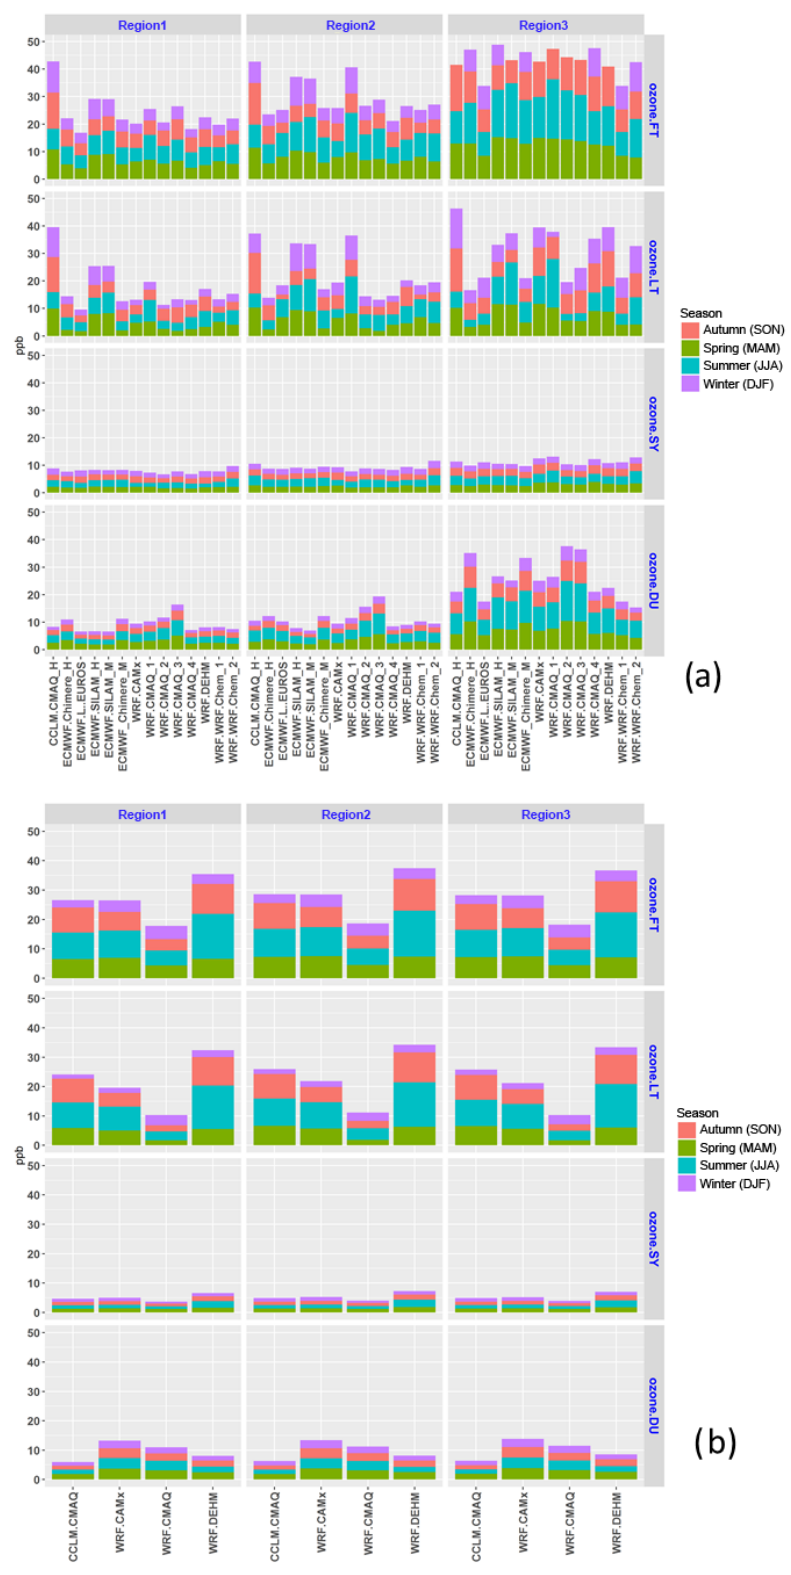
Figure 17. As in Fig. 9 but for